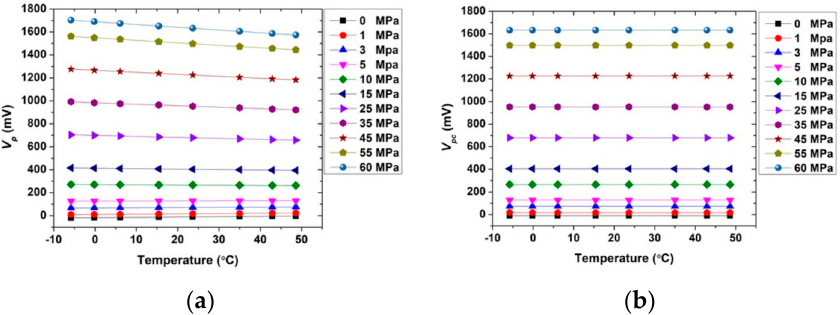
Figure 10. Temperature sensitivity change of pressure sensor ( a ) before compensation; ( b ) after compensation. compensation.